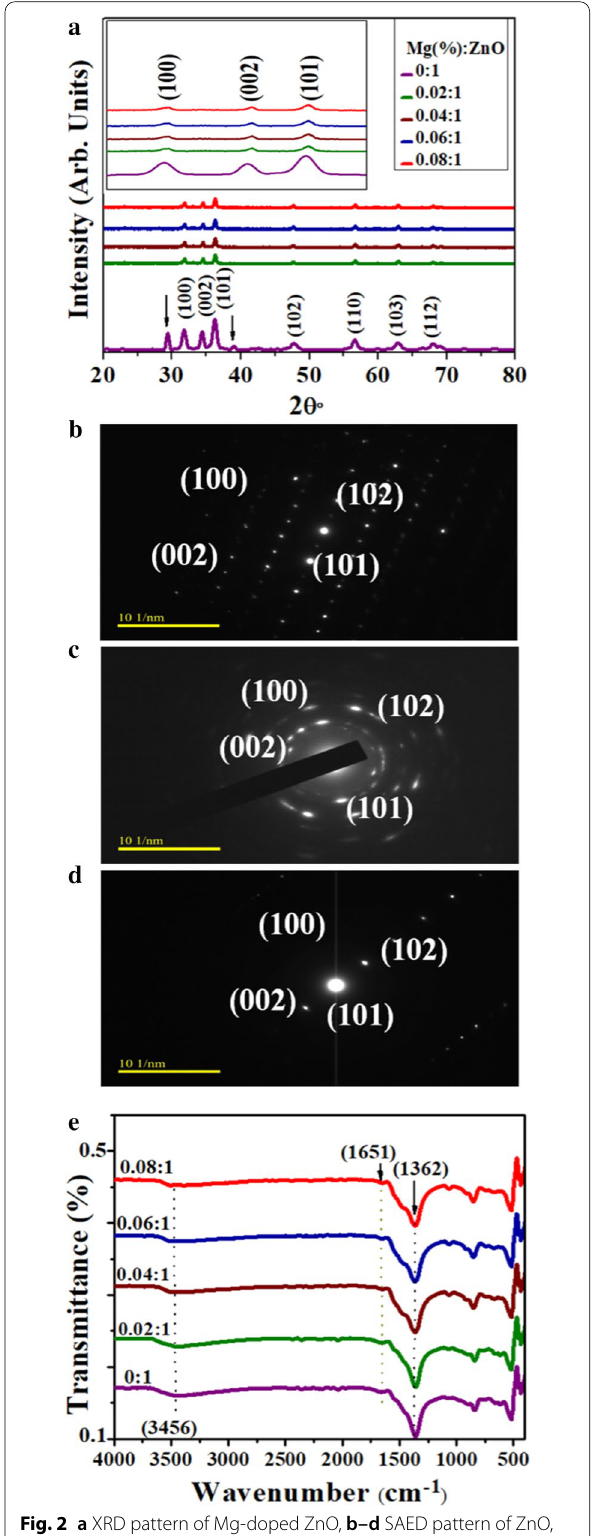
Fig. 2 a XRD pattern of Mg‑doped ZnO, b–d SAED pattern of ZnO, 4%, 8% of Mg‑doped ZnO and e FTIR spectra,